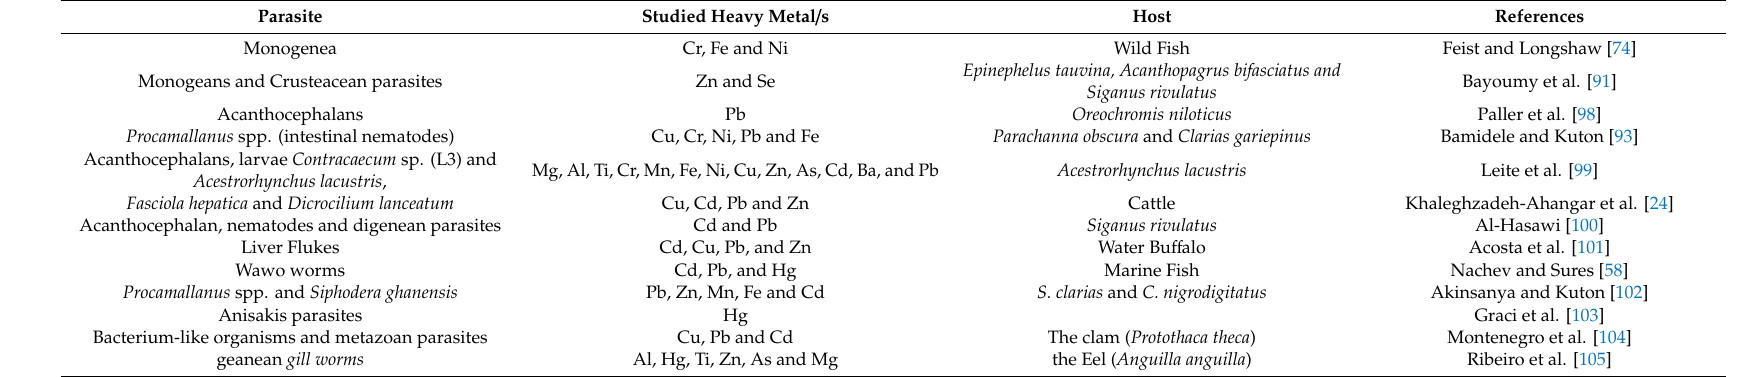
Table 3. Findings of some recent studies using parasites as biological indicators for heavy metals